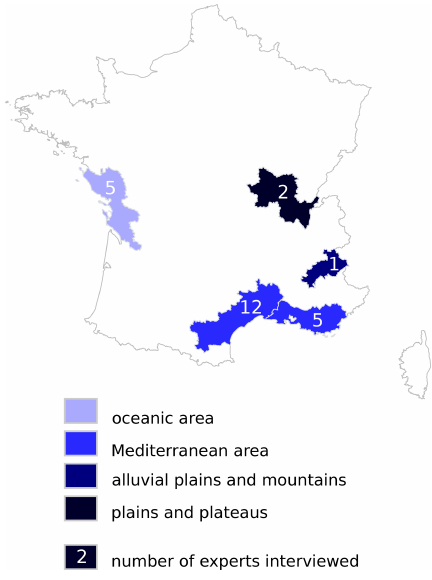
Figure 2. Geographic distribution of the experts